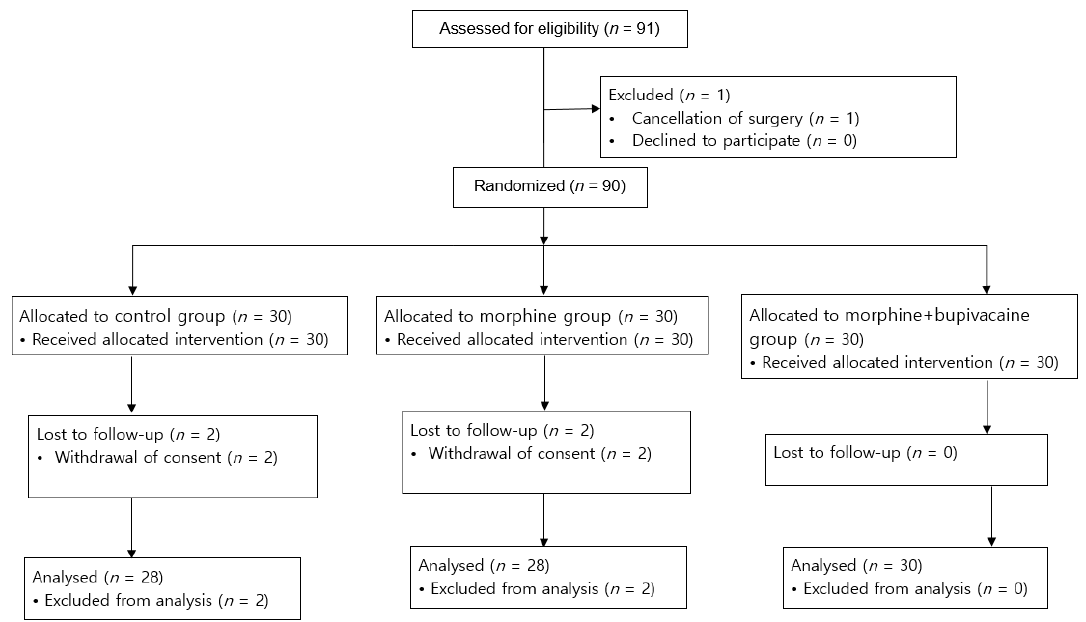
Figure 1. Flow diagram of the study selection process.